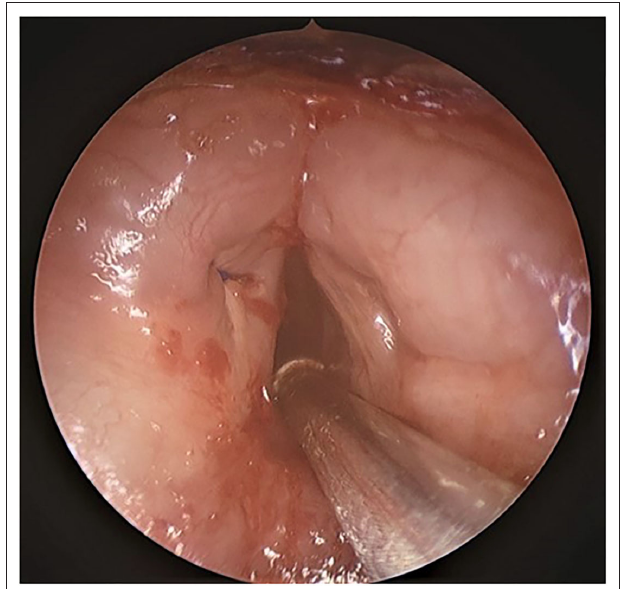
FIGURE 4 | Endoscopic view of the mucosal flap laterization. Suture is visible on the left vocal cord.